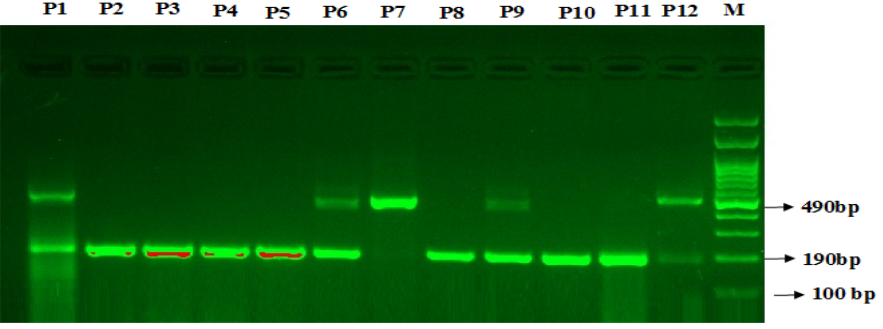
Figure 4. Mutation specific PCR for genotyping of VEGF I/D polymorphism in T2D subjects.